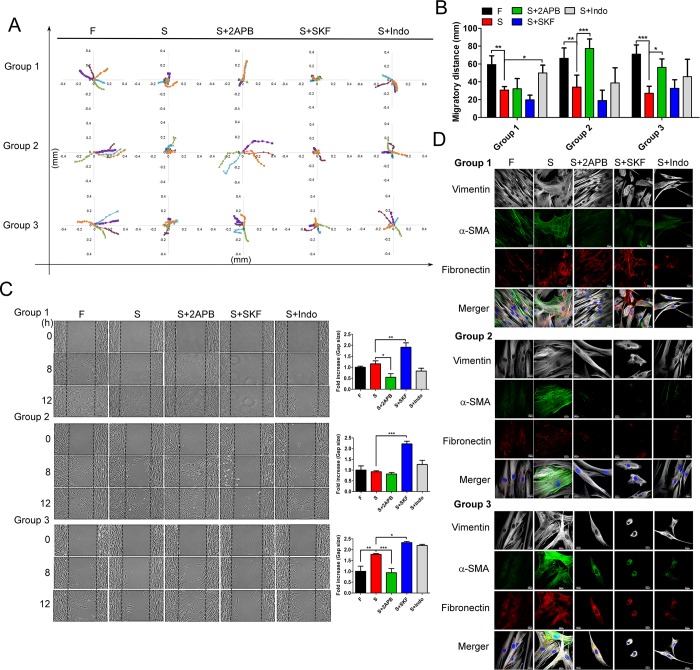
SOCE inhibitors contributed to cytoskeleton remodeling in SSc fibroblasts.(A) Detection of the effect of SOCE inhibitors, as indicated by the cell tracks in the three groups observed under an Olympus Cell^R IX81 fluorescence microscope for 12 h. The X and Y axes shows the migration distance in millimeters (mm). (B) Quantification of migratory distance as the (A) (n >20 cells, mean ± SD, *, p<0.05; **, p<0.01; ***, p<0.001). (C) The migratory ability of three groups was analyzed using a wound healing assay (mean ± SD, *, p<0.05; **, p<0.01; ***, p<0.001). To note, the Y axis showed the gap size, which stands for the empty area without cells. The data shown represent the average of three independent experiments. (D) Analysis of the distribution of vimentin, α-SMA and fibronectin in the three groups; SOCE inhibitors affected the cytoskeleton remodeling in SSc fibroblasts.